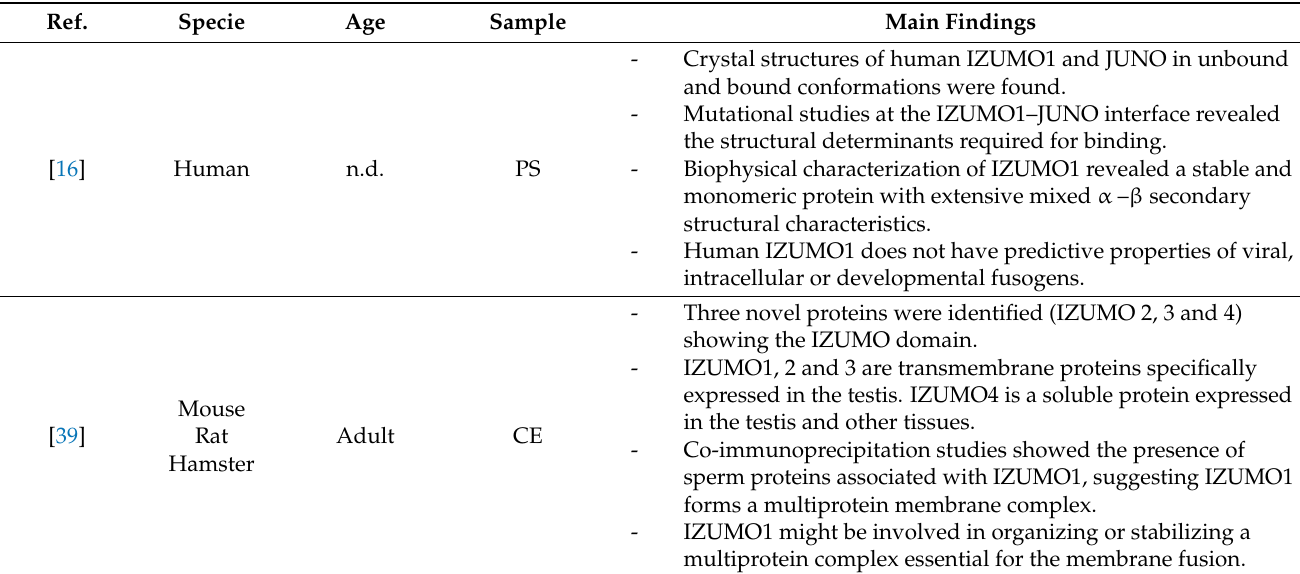
Table 3. Articles studying IZUMO1 characterization and